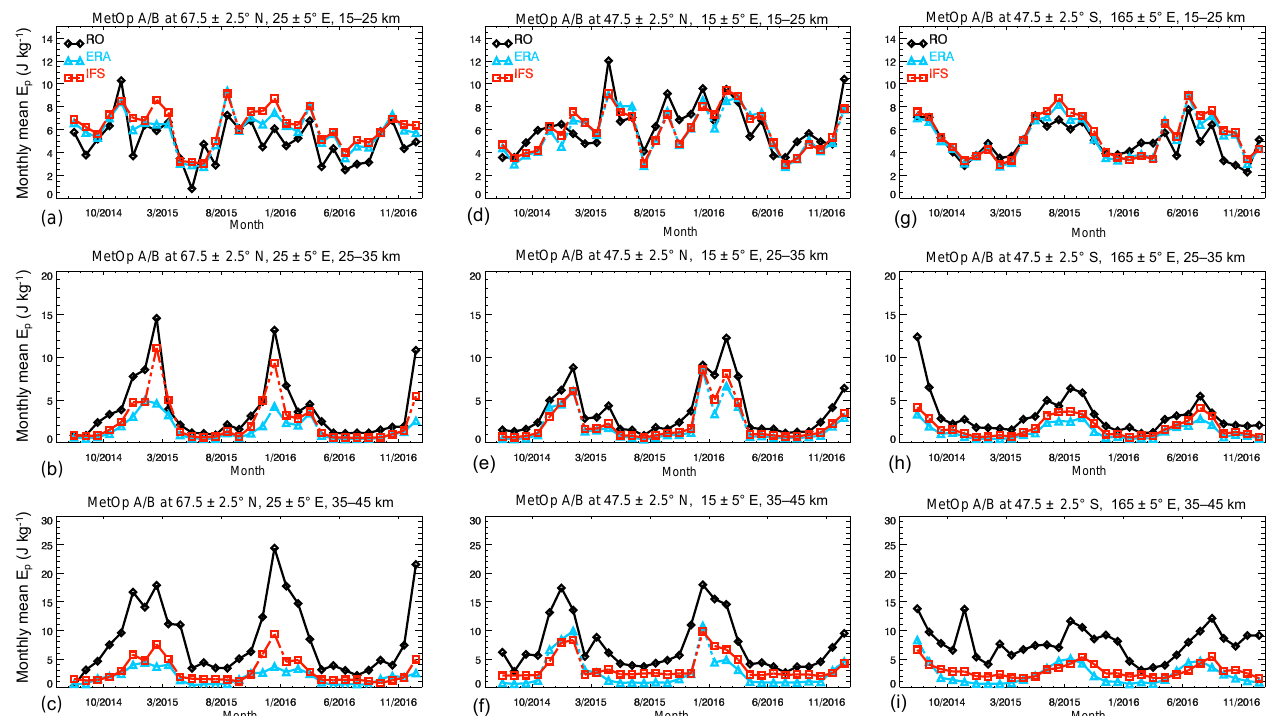
Figure 7. Comparison of time series of monthly mean E P from RO and model data (ERA-Interim and IFS) for three different locations: Sodankylä (a–c) , Bavarian Forest (d–f) , and Lauder (g–i) . The color code is explained in the insert. (a, d, g) , (b, e, h) and (c, f, i) are for altitude ranges of 15–25, 25–35, and 35–45, respectively.